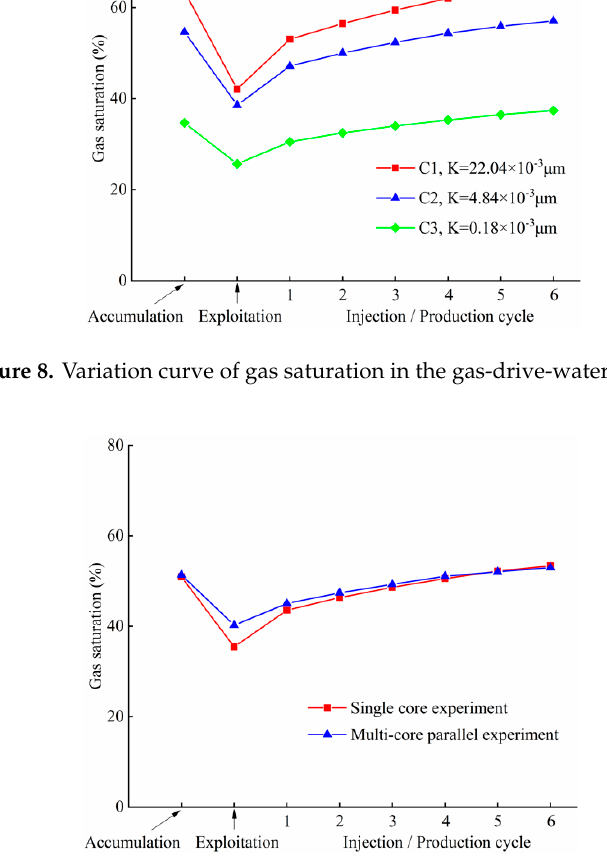
Figure 8. Variation curve of gas saturation in the gas-drive-water gas zone.